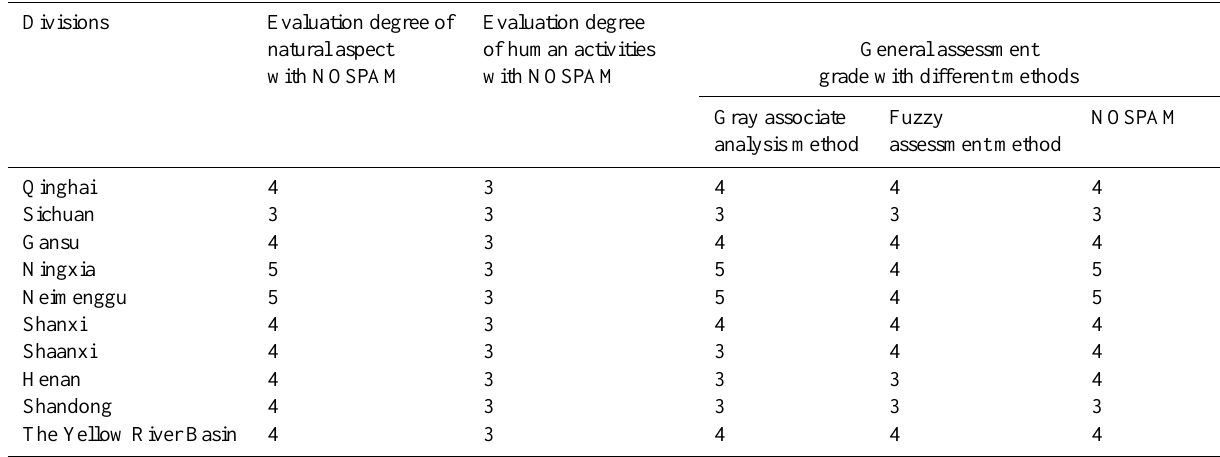
Table 7. The evaluation results of water resource renewability of the nine administrative divisions in the Yellow River Basin with different